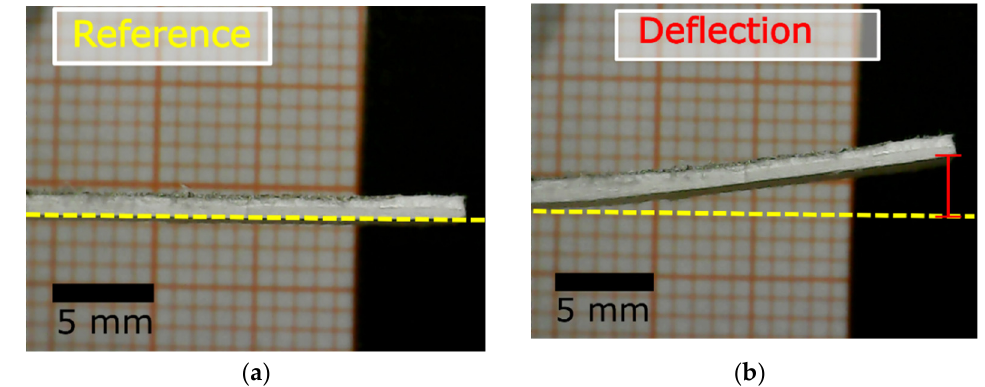
Figure 8. Deflection measurement of the free end of the sample to measure the displacement changes with respect to the reference line: ( a ) Reference guideline; ( b ) Measure deflection.